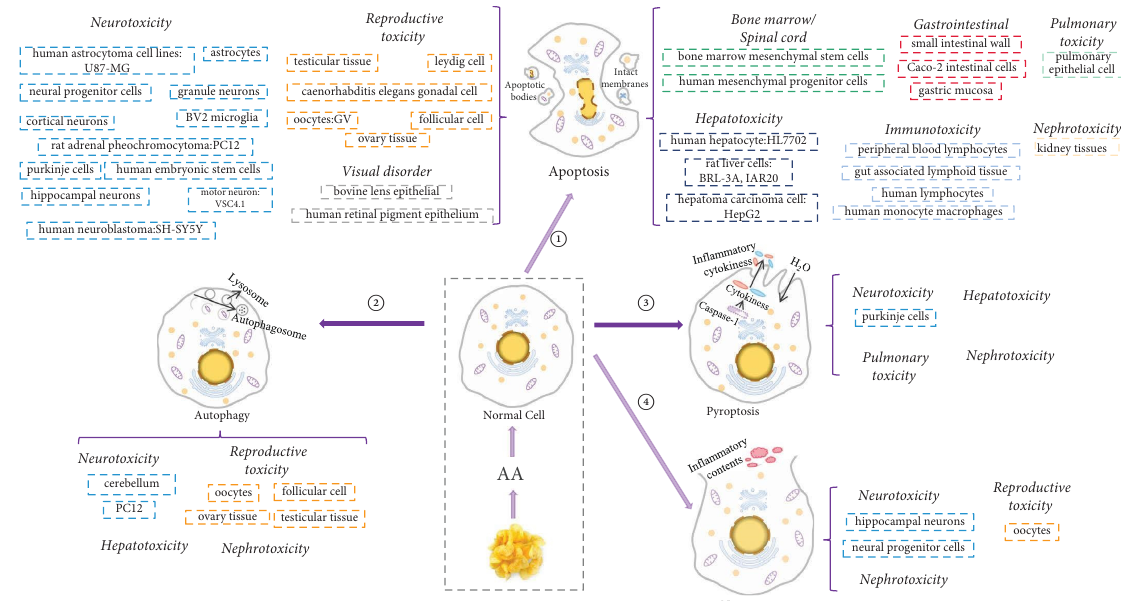
Figure 7: AA can induce PCD in diferent cell types. Te picture shows roughly four types of